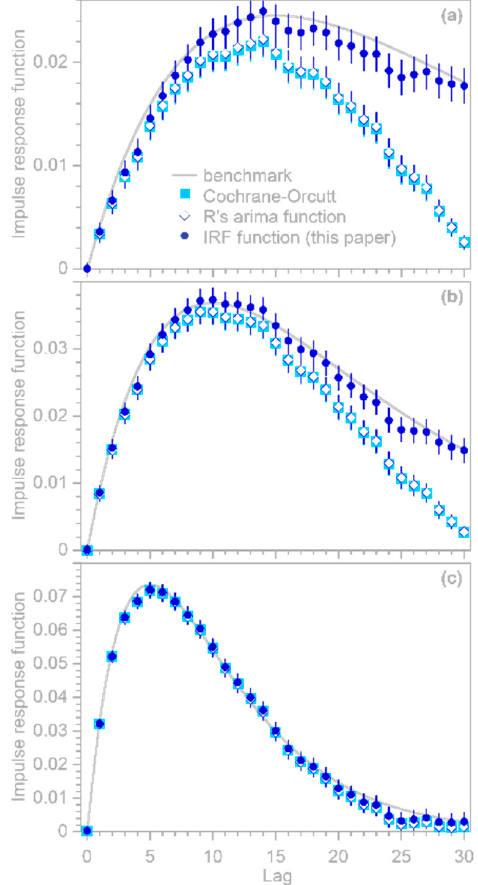
Figure 1. Impulse response functions estimated by the Cochrane–Orcutt procedure (Equations (9)–(11), light blue squares), R’s 𝑎𝑟𝑖𝑚𝑎 function (open diamonds), and the 𝐼𝑅𝐹 function presented here (Equations (12)–(26), dark blue circles). Gray lines show benchmark convolution kernels (gamma distributions with shape factor 𝛼 = 2 and means 𝜏 of 30, 20, and 10 lag units in panels ( a ), ( b ), and ( c ), respectively), which were convolved with a Gaussian white noise time series of length 𝑛 = 2000 to simulate the system output. First ‐ order autoregressive noise with 𝜌 = 0.9 was added to the system output at a signal ‐ to ‐ noise ratio of 4. The autoregressive coefficient of 𝜌 = 0.9 was sup ‐ plied as a known parameter to the Cochrane–Orcutt procedure and R’s 𝑎𝑟𝑖𝑚𝑎 function. Impulse response functions estimated by the Cochrane–Orcutt procedure and R’s 𝑎𝑟𝑖𝑚𝑎 function (light blue squares and open diamonds, respectively) converge to nearly zero within the range of analyzed lags, even if the true convolution kernel does not (panels ( a ) and ( b )). If the true convolution kernel converges to nearly zero within the range of analyzed lags (which will not be known in practice), all three methods yield nearly identical results (panel ( c )).